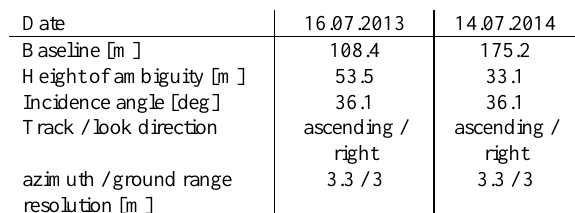
Table 2: Properties of the used TanDEM-X bistatic image